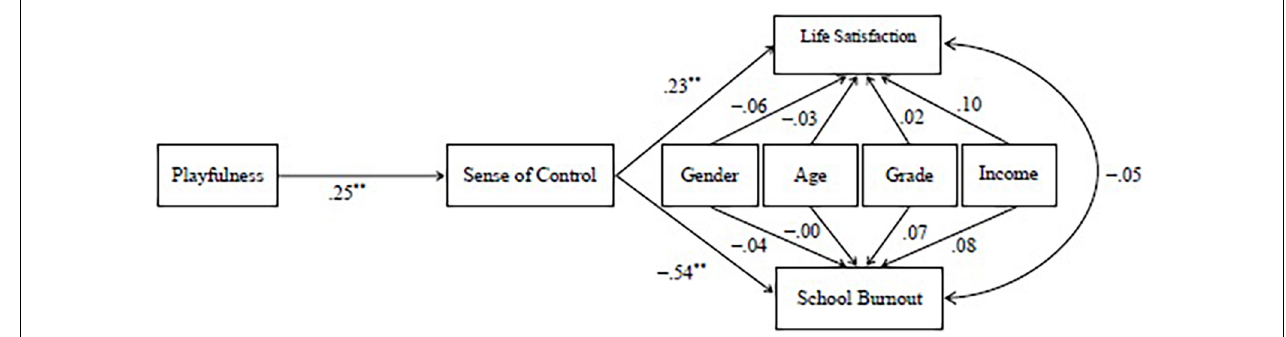
FIGURE 1 | Path coefficients of the hypothesized model. N = 353. Standardized path coefficients are reported here. **p < 0.01.